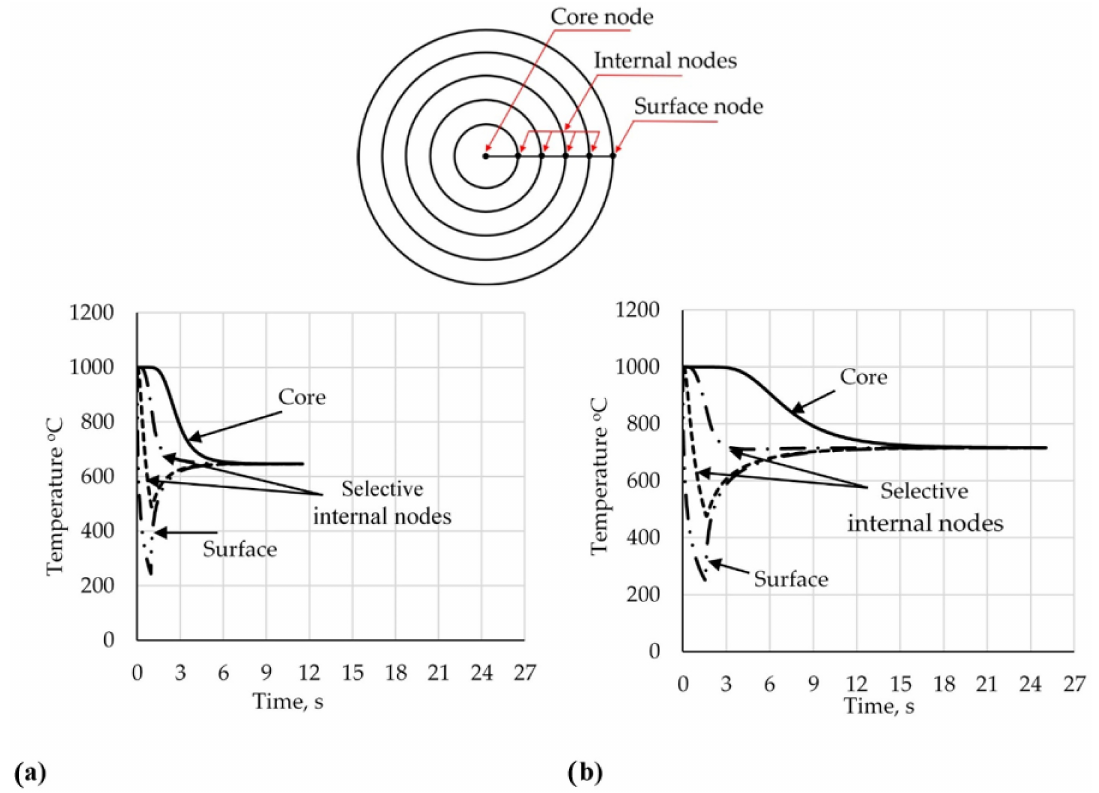
Figure 9. Evolution of thermal cycles in the core as well as surface zones during processing of D20 ( a ) and D32 ( b ) rebars.